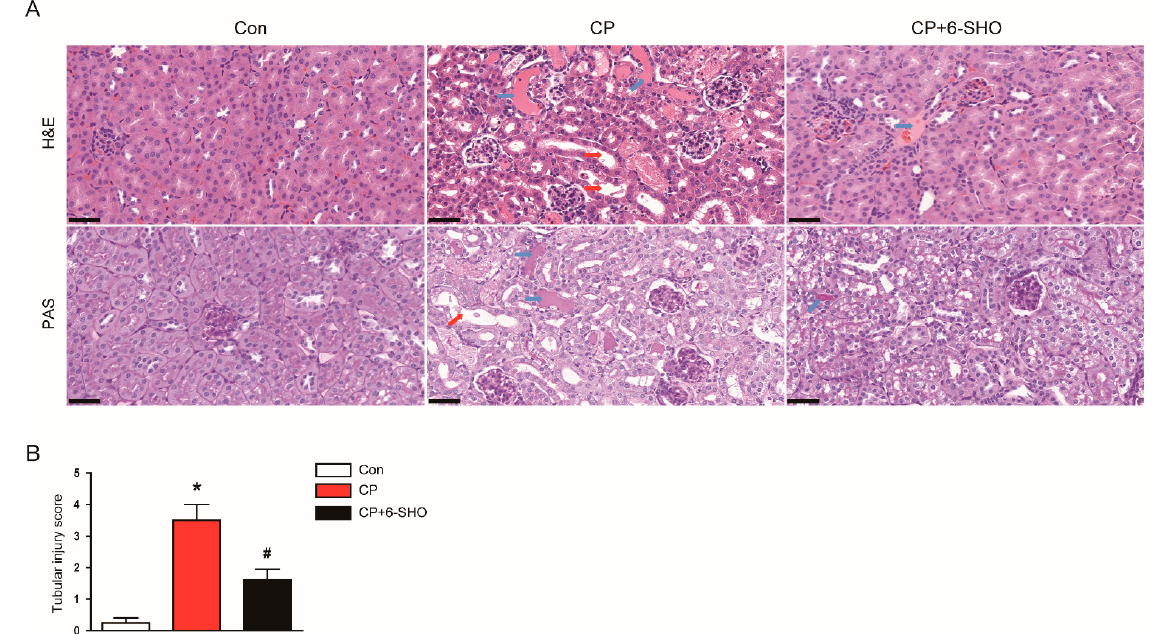
Figure 2. Effect of 6-shogaol on histological abnormalities in cisplatin-treated mice. ( A ) Representative images of hematoxylin and eosin (H&E) or periodic acid-Schiff (PAS) staining of renal cortex. Scale bar = 40 μ m. Red arrows indicate tubular dilatation. Blue arrows indicate cast deposition in the lumens of tubules. ( B ) Tubular injury was semiquantitatively scored using PAS-stained sections. n = 8 per group of mice. * p < 0.05 versus Con. # p < 0.05 versus CP.